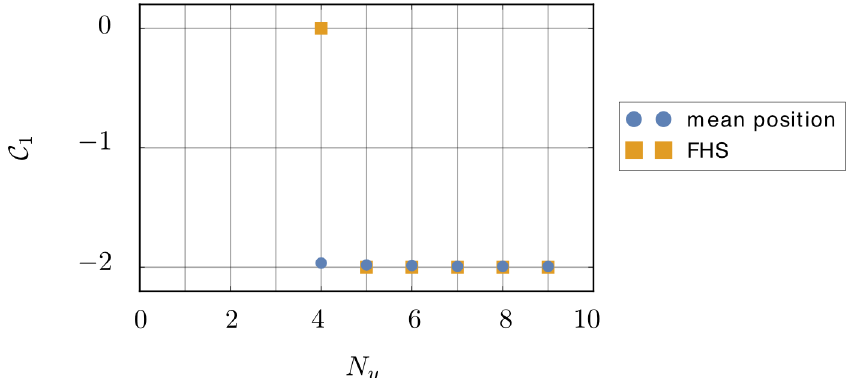
∈ [ 3,9 ] , measured y > 5, y = − 2 π/ 5 d , x